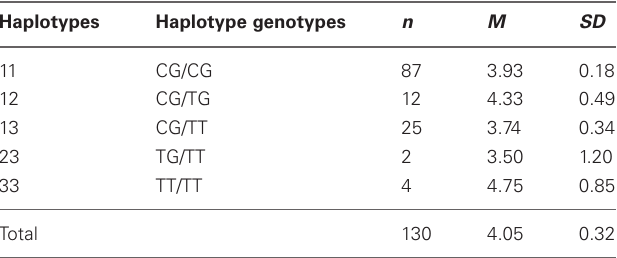
Table 5 | Descriptive statistics (means and standard deviations) for second mover decisions in the UG (minimal acceptable offers) dependent on haplotypes constituted by rs1800497 and